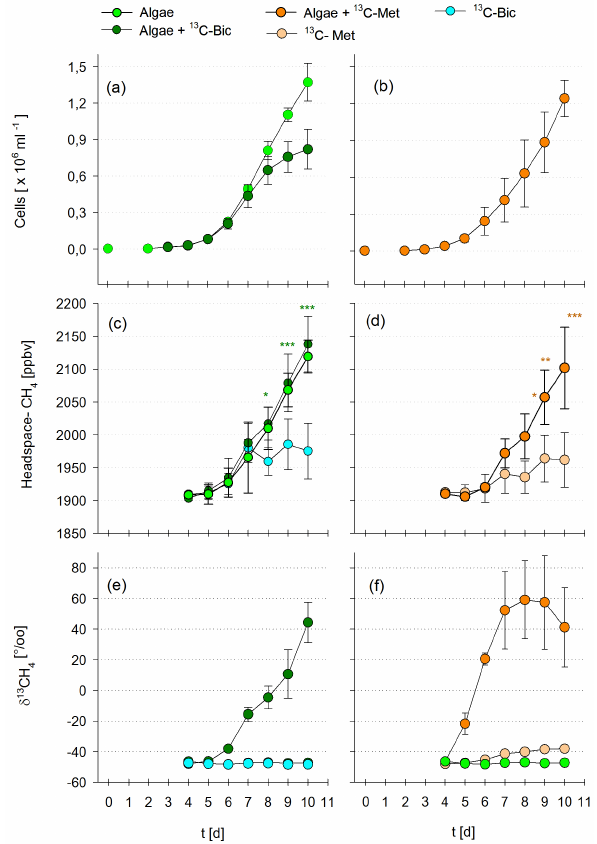
Figure 2. Culture cell density when algae grown in seawater ( n = 2) supplemented with (a) Bic or (b) Met ( n = 3) and headspace-CH 4 mixing ratio for cultures supplemented with (c) Bic or (d) Met. δ 13 CH 4 values after addition of (e) 13 C-Bic and (f) 13 C-Met ( n = 3; error bars mark the standard deviation). Stars mark the signifi- cance between algae + 13 C-Bic and “seawater + 13 C-Bic” or be- tween algae + 13 C-Met and “seawater + 13 C-Met”, with * p ≤ 0 . 05; ** p ≤ 0 . 01; *** p ≤ 0 . 001.